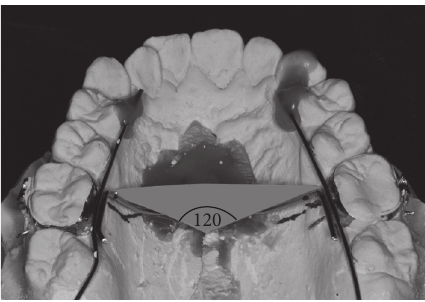
Figure 2: The angle between the two force vectors of the two nickel- titanium closed coil springs was controlled to be 120 ∘ .